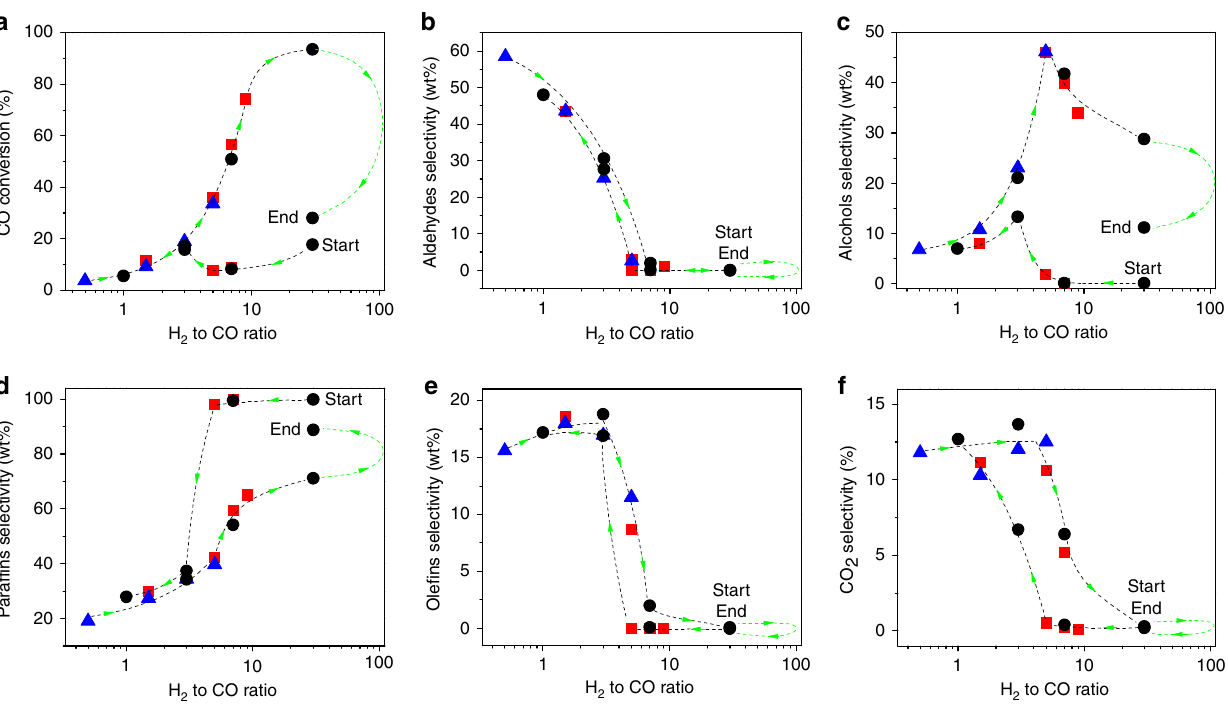
Fig. 1 Kinetic hysteresis in the catalytic CO hydrogenation. a CO conversion; b – e selectivities of aldehydes, alcohols, paraf fi ns and ole fi ns, respectively (ex CO 2 ); f CO 2 selectivity. The same batch of catalyst is tested independently three times (circle), (square), and (triangle) over 0.5 g Co 4 Mn 1 K 0 . 1 at 220 °C, 40 bar, and GHSV = 3600 h − 1 . During each run, the P H2 /P CO ratio is varied systematically as follows: (circle) 30/1 → 7/1 → 3/1 → 1/1 → 7/1 → 30/1 → 30/1 (after H 2 treatment for 8 h: green dashed line), (square) 7/1 → 5/1 → 1.5/1 → 5/1 → 7/1 → 9/1, (triangle) 0.5/1 → 1.5/1 → 3/1 → 5/1. Each data point re fl ects quasi-steady-state conditions after 12 h time-on-stream